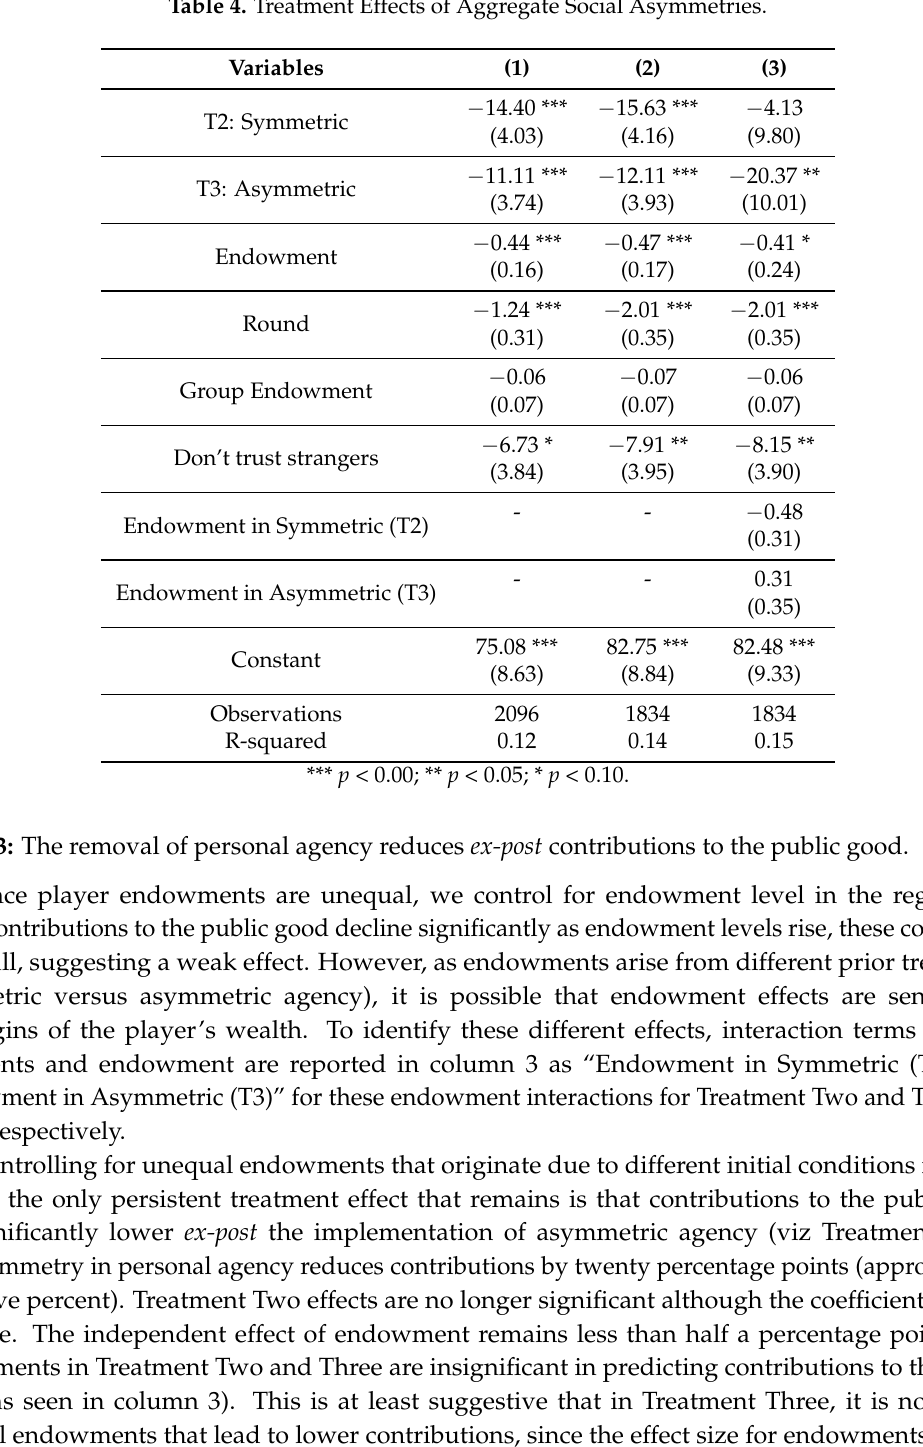
Table 4. Treatment Effects of Aggregate Social